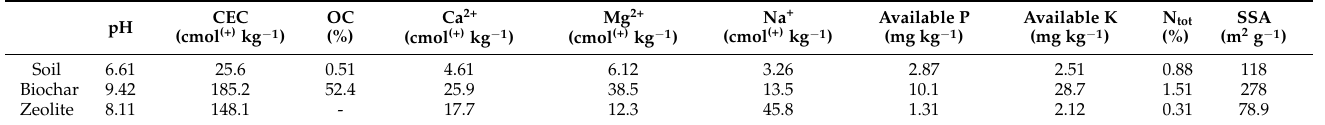
Table 1. Chemical characteristics of soil and applied